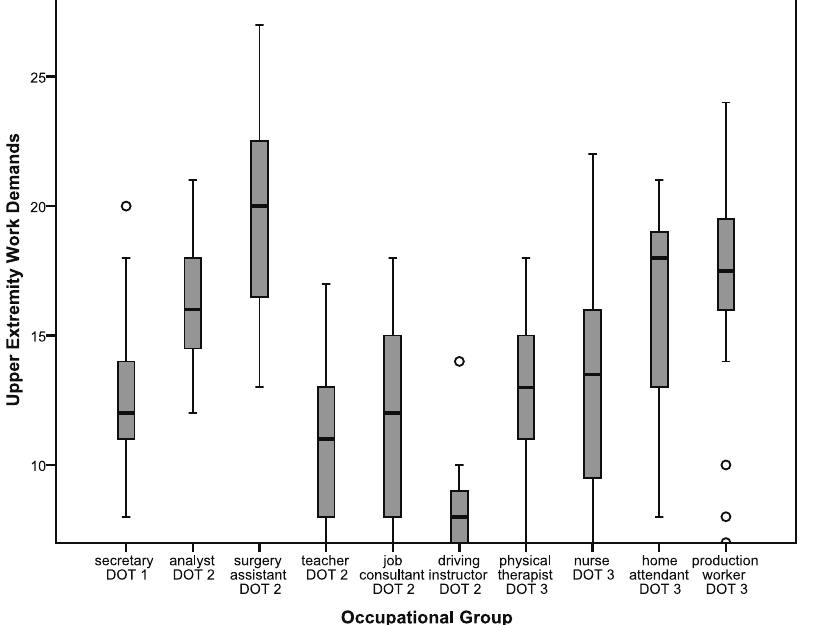
Figure 2. Variance in occupational groups. DOT Dictionary of Occupational Titles; Scoring range of the Upper Extremity Work Demands: 7–28.